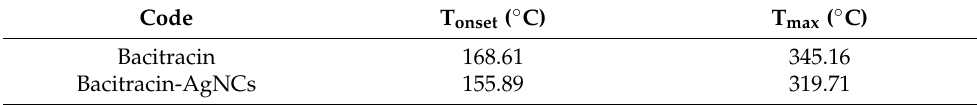
Figure 3. ( A ) FESEM images of bacitracin and ( B ) Bacitracin-AgNCs. ( C , D ) HR-TEM images of Bacitracin-AgNCs (inset: histogram particle size distribution of Bacitracin-AgNCs by DLS). ( E ) Thermal gravimetric analysis (TGA) curves of bacitracin and Bacitracin-AgNCs. ( F ) Differential thermogravimetry (DTG) curves of bacitracin and Bacitracin-AgNCs. Table 1. Thermal properties results of bacitracin and